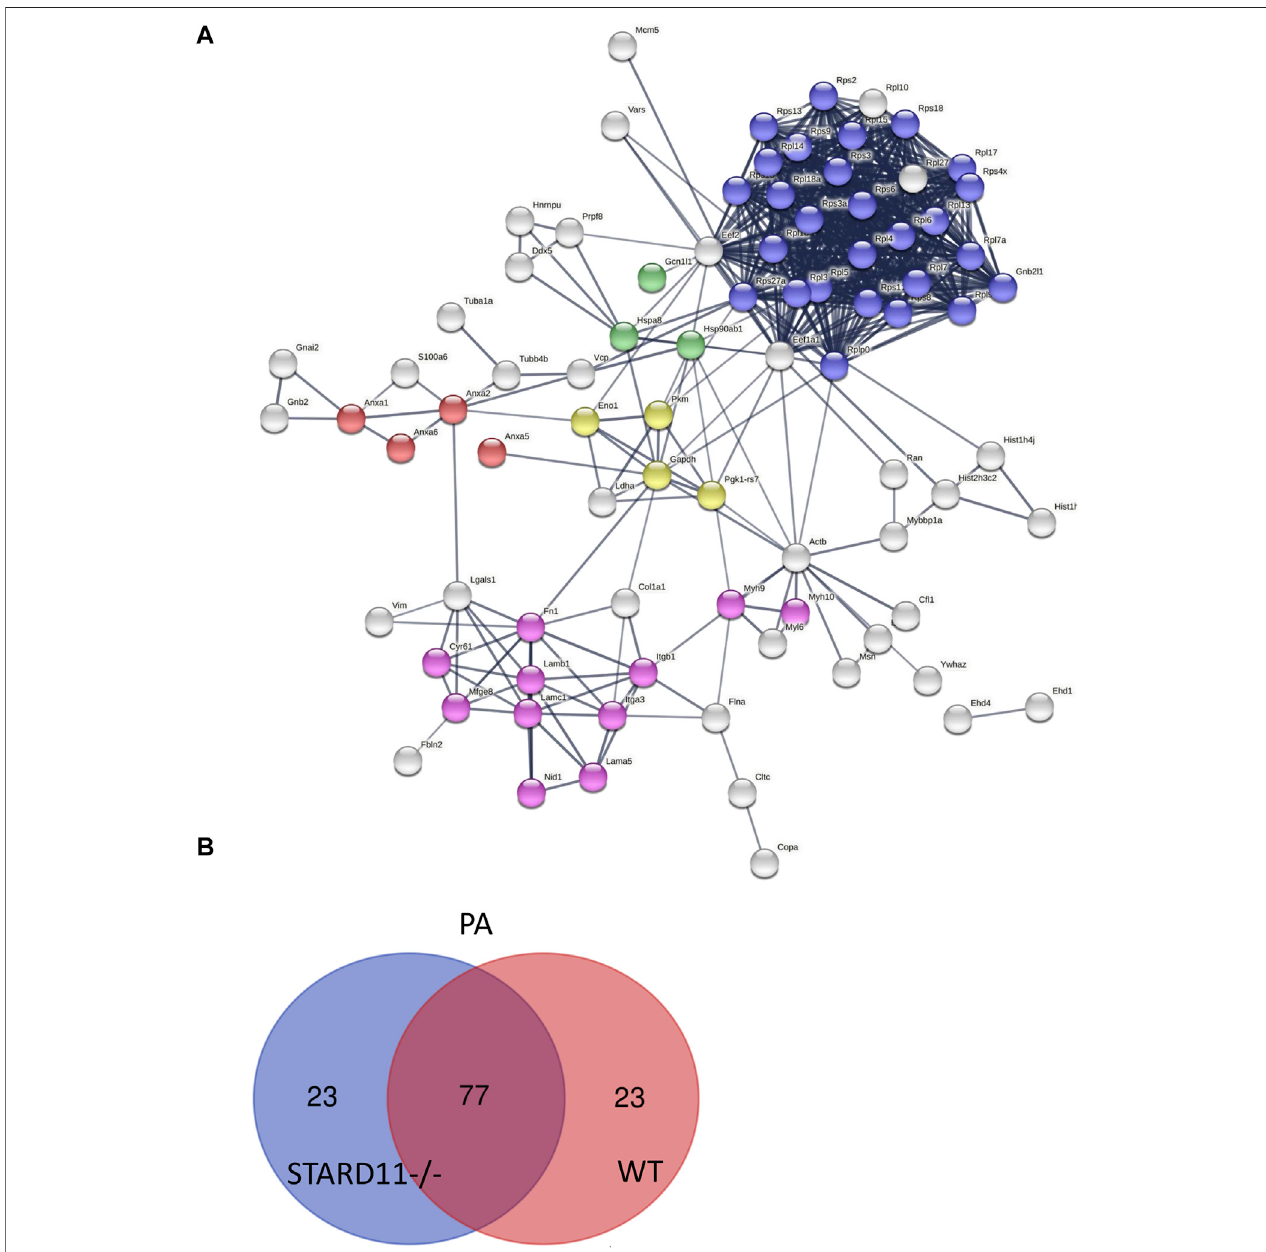
FIGURE5| Predictedprotein – proteininteractionsamongSTARD11-/-EVproteins. (A) Protein – proteininteractionanalysiswasperformedbySTRINGsoftwareon STARD11-/- PAtop 100expressed proteins; red color shows annexin family proteins; blue colorrepresentsribosomal proteins; green colorrepresentsstress response proteins; yellow color represents glycolysis proteins; and pink color represents cell adhesion proteins. (B) The Venn diagram represents the number of common and unique proteins between STARD11-/- PA and WT PA EV proteins.